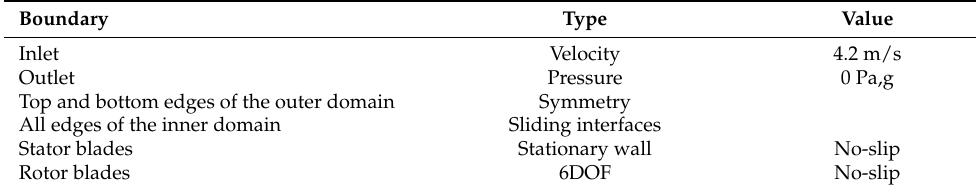
Table 1. Boundary conditions specified to the numerical model.